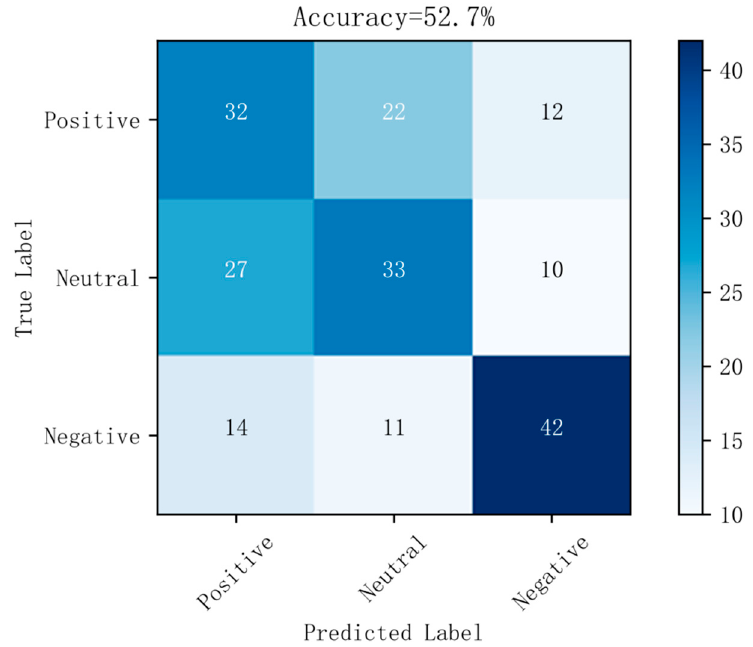
Figure 6. Confusion matrix in original dataset with RF.